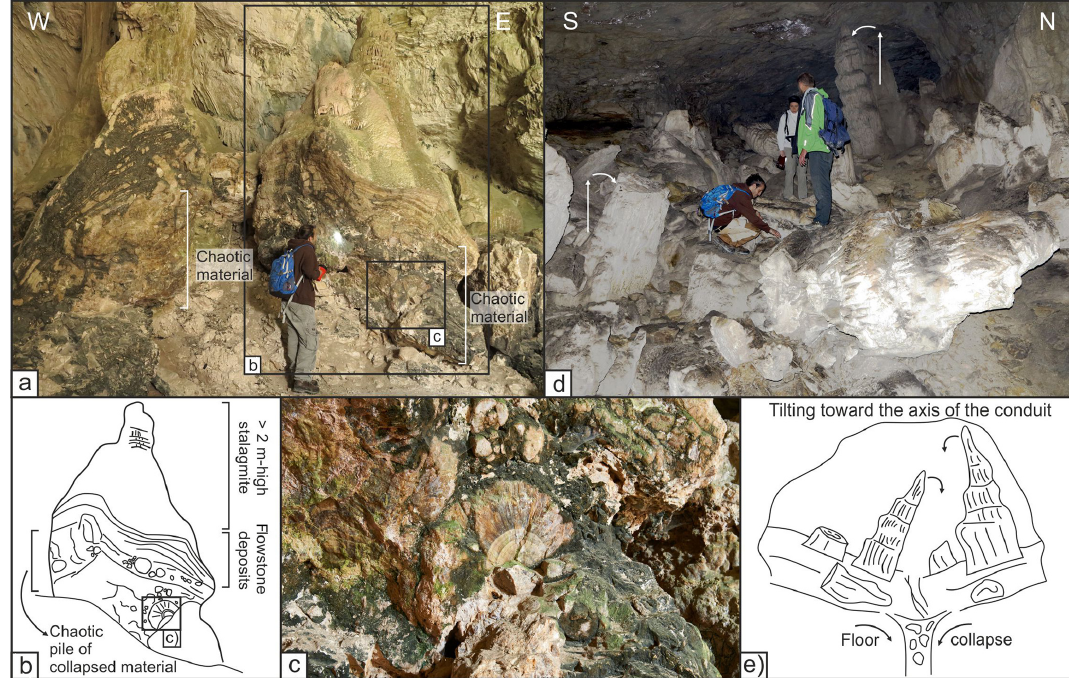
Figure 3. (a) Superposed multiple phases of large collapses and concretions near the entrance of the cave. Meter-scale large stalagmites grew on top of thick piles of chaotic materials, draped by flowstone deposits (sketch of b ), within which large portions of concretions tens of centimeters thick are involved (close-up of c ). (d) Great collapses involving meter-scale large stalagmites in the “Galleria della Devastazione”. Stalagmites still standing upright show a clear tilting toward the axis of the conduit, probably as a consequence of floor sinking (see sketch of e ). See Fig. 2d for sites